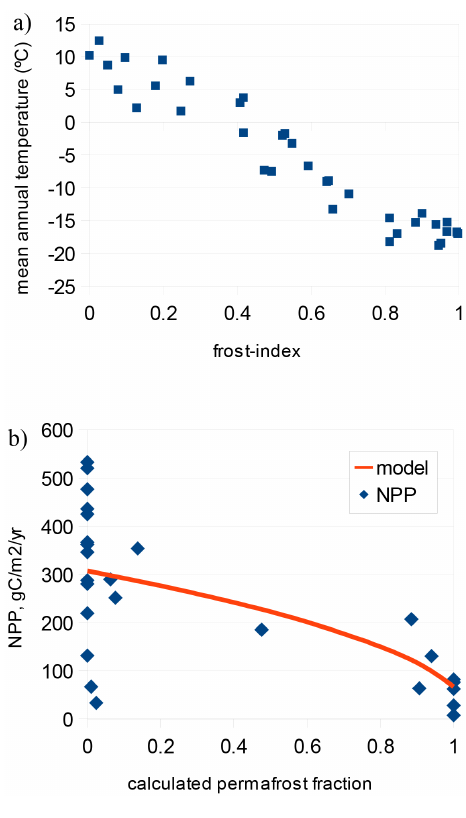
Figure A2. Relationships between frost index and MAT on the CLIMBER-2 grid scale (data from Zhang, 1998; Jones et al., 1999). Frost index determines permafrost fraction according to the model described in Sect. 3.2 (main text). NPP data for the permafrost zone from MODIS plotted against permafrost fraction (calculated from frost index values of Zhang, 1998) on the CLIMBER-2 grid